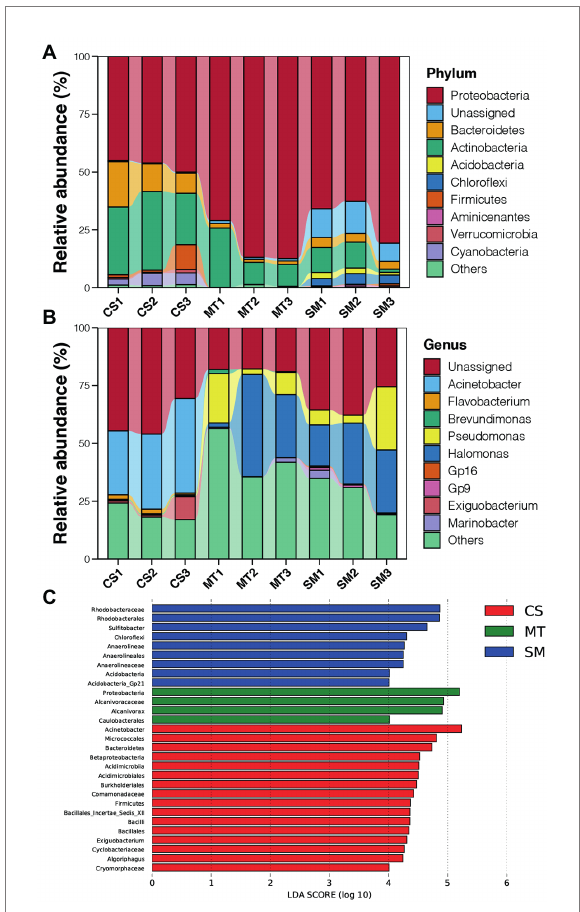
FIGURE 2 (A) Relative abundances of dominant bacterial phyla in sediments of CS, MT, and MS groups. (B) Relative abundances of dominant bacterial genera in sediments of CS, MT, and MS groups. (C) The LEfSe analysis results of sediment microbial communities among CS, MT, and MS groups. Linear discriminant analysis (LDA) score was used to discover biomarkers in different ecosystem groups. The threshold value was log10 (LDA score) >